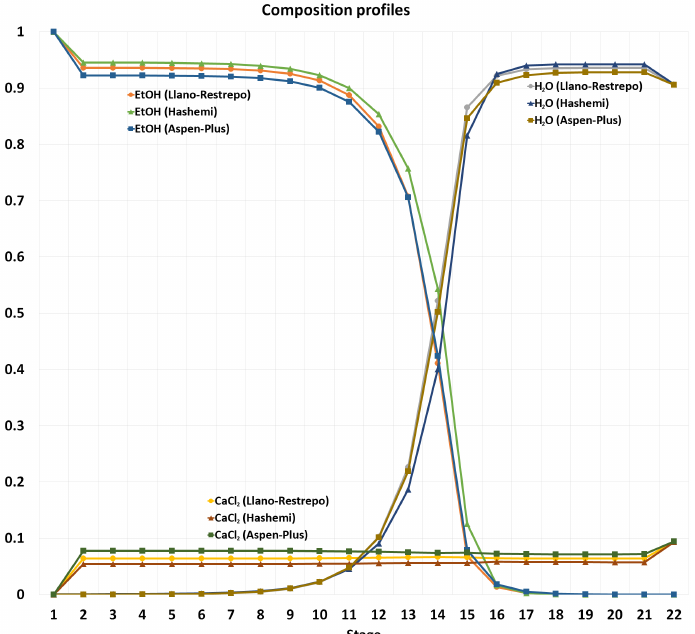
Figure 3. Comparison of the composition profiles of the saline extractive distillation column simula- tion. Aspen Plus ® vs. Llano − Restrepo et al. and Hashemi et al. [16,33].